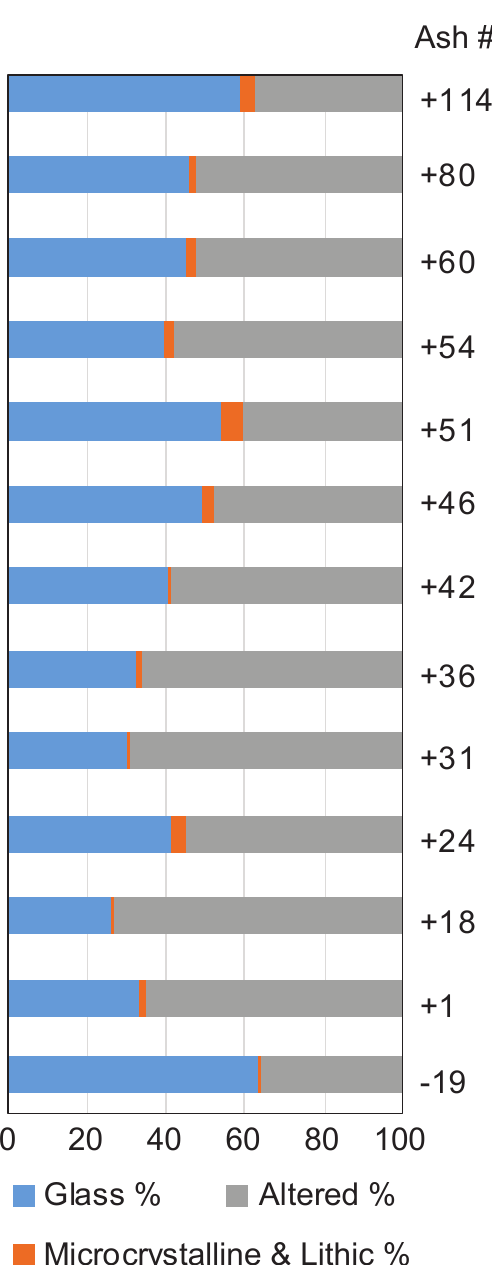
Figure 9: Graph showing relative amount (of total amount of grains counted in SEM images; e.g. Figure 6) of pristine glass, altered grains, and microcrystalline and lithics in each sample. Data in Table S4, Supple- mentary